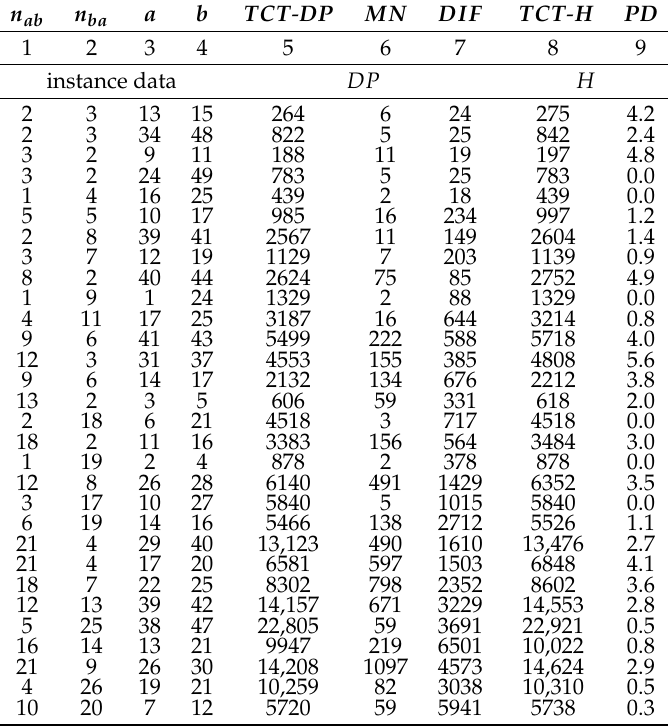
Table 1. Detailed results with Algorithm DP and Heuristic H for 30 randomly selected instances. n ab n ba